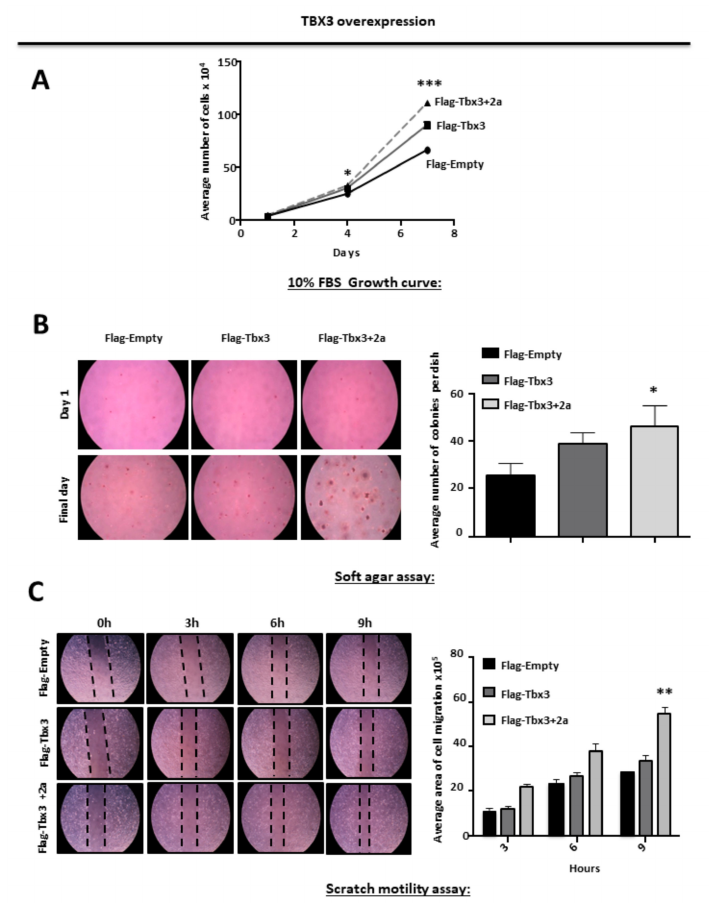
Figure 2. TBX3 overexpression promotes proliferation, anchorage-independent growth and migration of ERMS cells. ( A ) Growth curve analyses of ERMS (RD) Flag-Empty, Flag-Tbx3 and Flag-Tbx3 + 2a cell lines. ( B ) RD Flag-Empty, Flag-Tbx3 and Flag-Tbx3 + 2a cell lines were suspended in soft-agar medium slurry and allowed to proliferate for 14 days. Whole dishes were stained with p-iodinitrotetrazolium. (Left) Representative images are shown (200 × magnification). (Right) Quantification of at least 40 fields of view from four independent experiments. ( C ) Cell motility assays were performed to measure the migration of RD Flag-Empty, Flag-Tbx3 and Flag-Tbx3 + 2a cells. A linear wound was made on confluent cells and distance migrated was measured at 3, 6 and 9 h. The values in the graphs represent the mean of at least four independent experiments ± SEM (* p < 0.05, ** p < 0.001, *** p <